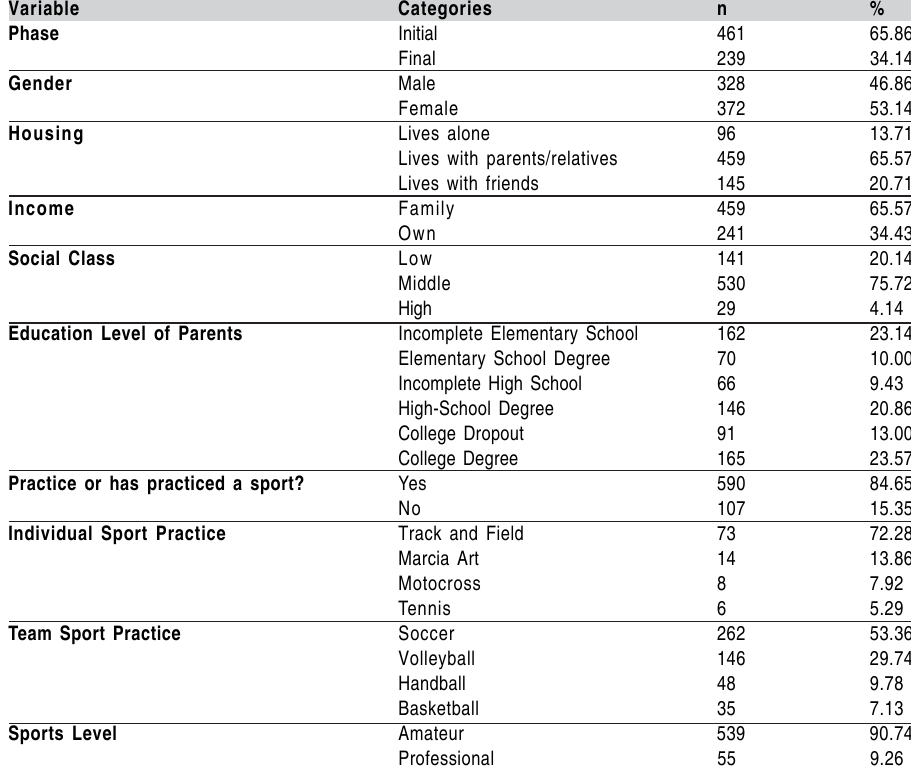
Table 1. Distribution of university students according to period of courses, gender, housing, income, social class and education level of parents, and profile of sport practice. Joaçaba, SC, Brazil, 2005.